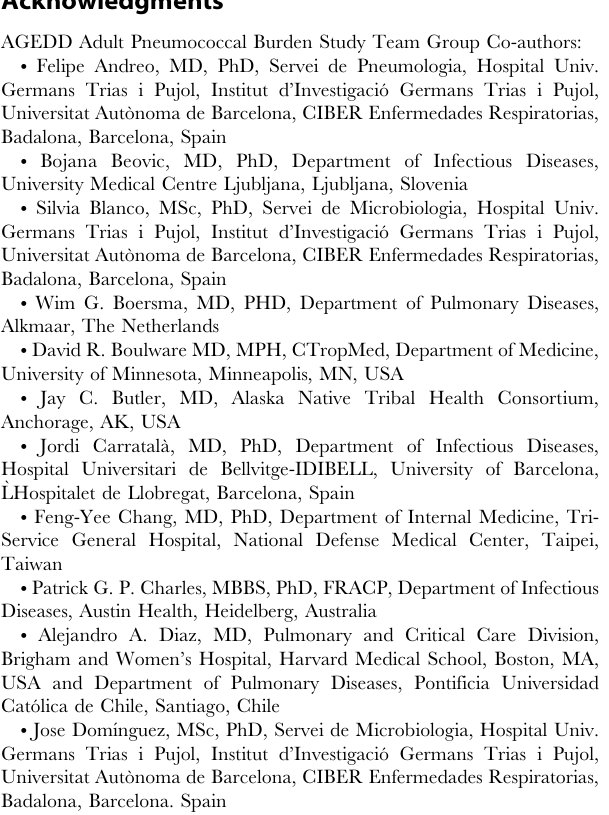
Figure S1 The relationship between diagnostic testing and the proportion of CAP attributable to pneumococ-